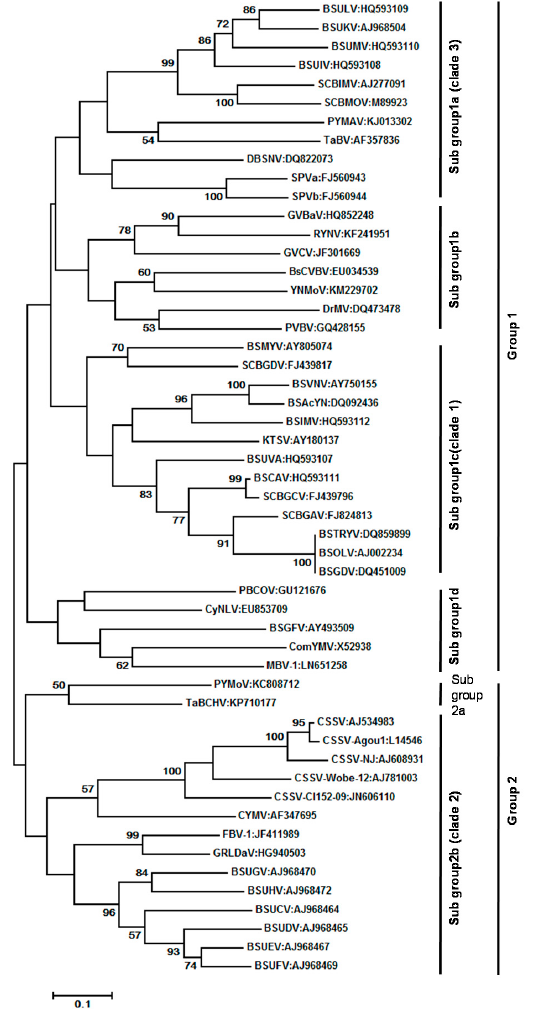
Figure 6. Maximum likelihood phylogeny of 52 badnavirus isolates representing different species based on alignment of a 540-bp fragment of the RT/RNase H viral region. Bootstrap values of 1000 replicates are given when >50%. The tree is drawn to scale, with branch lengths measured in the number of substitutions per site. Details of acronyms used are provided in Supplementary Materials Table S1. The GenBank accession numbers of sequences are given in parentheses. Clades 1, 2,and 3 shown in the figure areas per the phylogeny analysis [46].